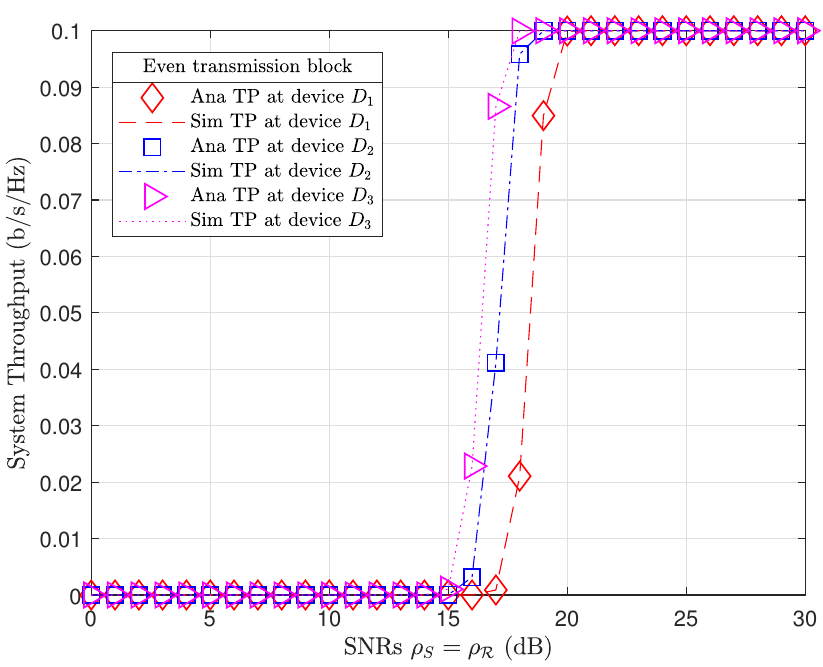
Figure 6. System throughput in even transmission blocks.